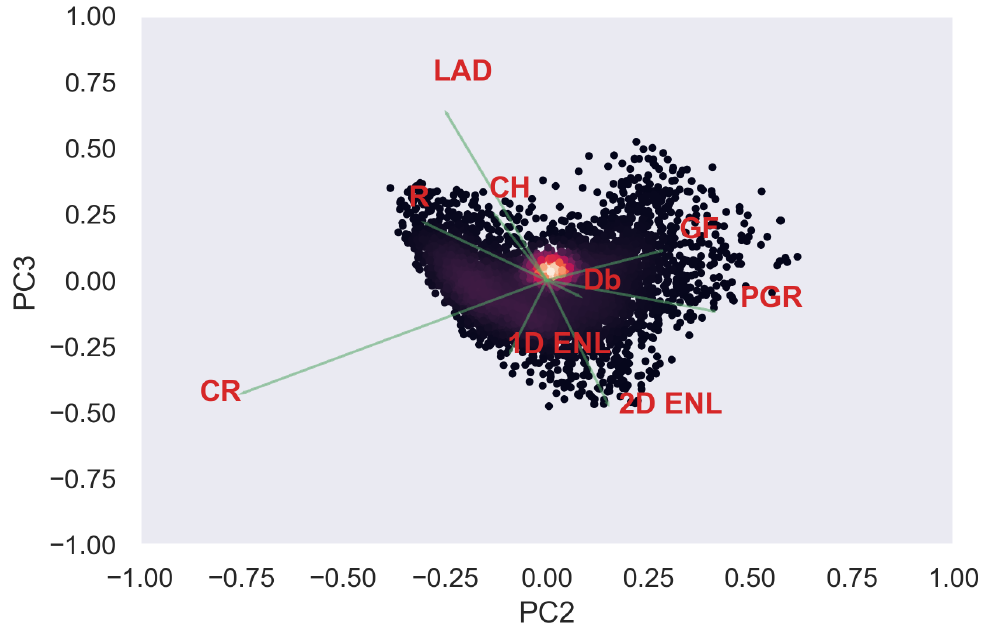
Figure A38. TLS PCA band 2 and 3 loadings at 1m grid